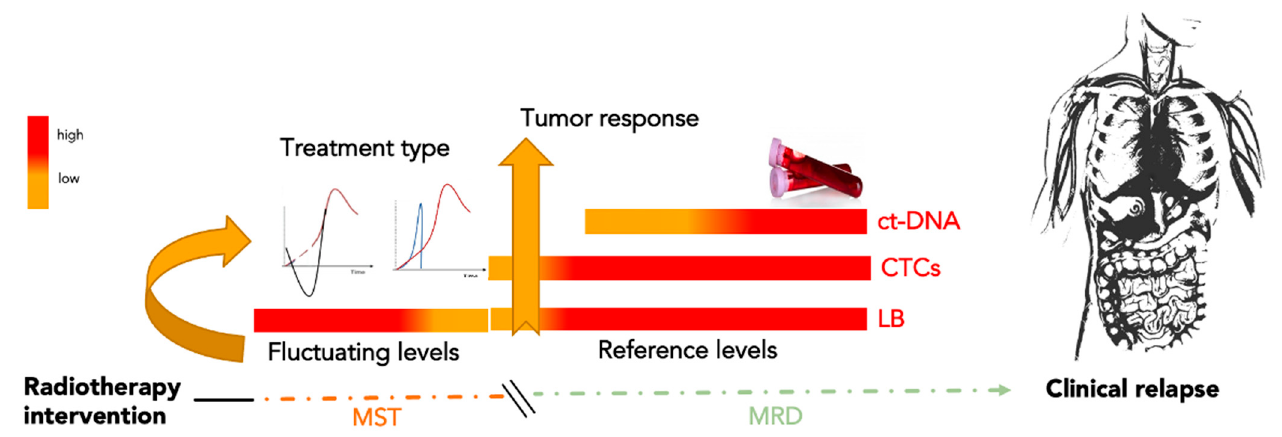
Figure 4. Molecular sedimentation time. Molecular sedimentation time (MST) is the period of latency between the first IO treatment and biomarker collection. During this period, interfering factors existing in the blood are produced prevalently by healthy tissue around the treated tumor lesion. Monitoring of minimal residual disease (MRD) begins with the first specific circulating tumor biomarker available. CTCs, being highly specific to tumor disease, are candidates to be a good marker for qualifying MRD by reducing the MST duration induced by IO. After MST, further combined analysis of CTCs and ct-DNA could represent a better surveillance approach for a longitudinal scan of MRD. Note: MST, molecular sedimentation time; MRD, minimal residual disease; ct-DNA, circulating tumor DNA; CTCs, circulating tumor cells, LB, liquid